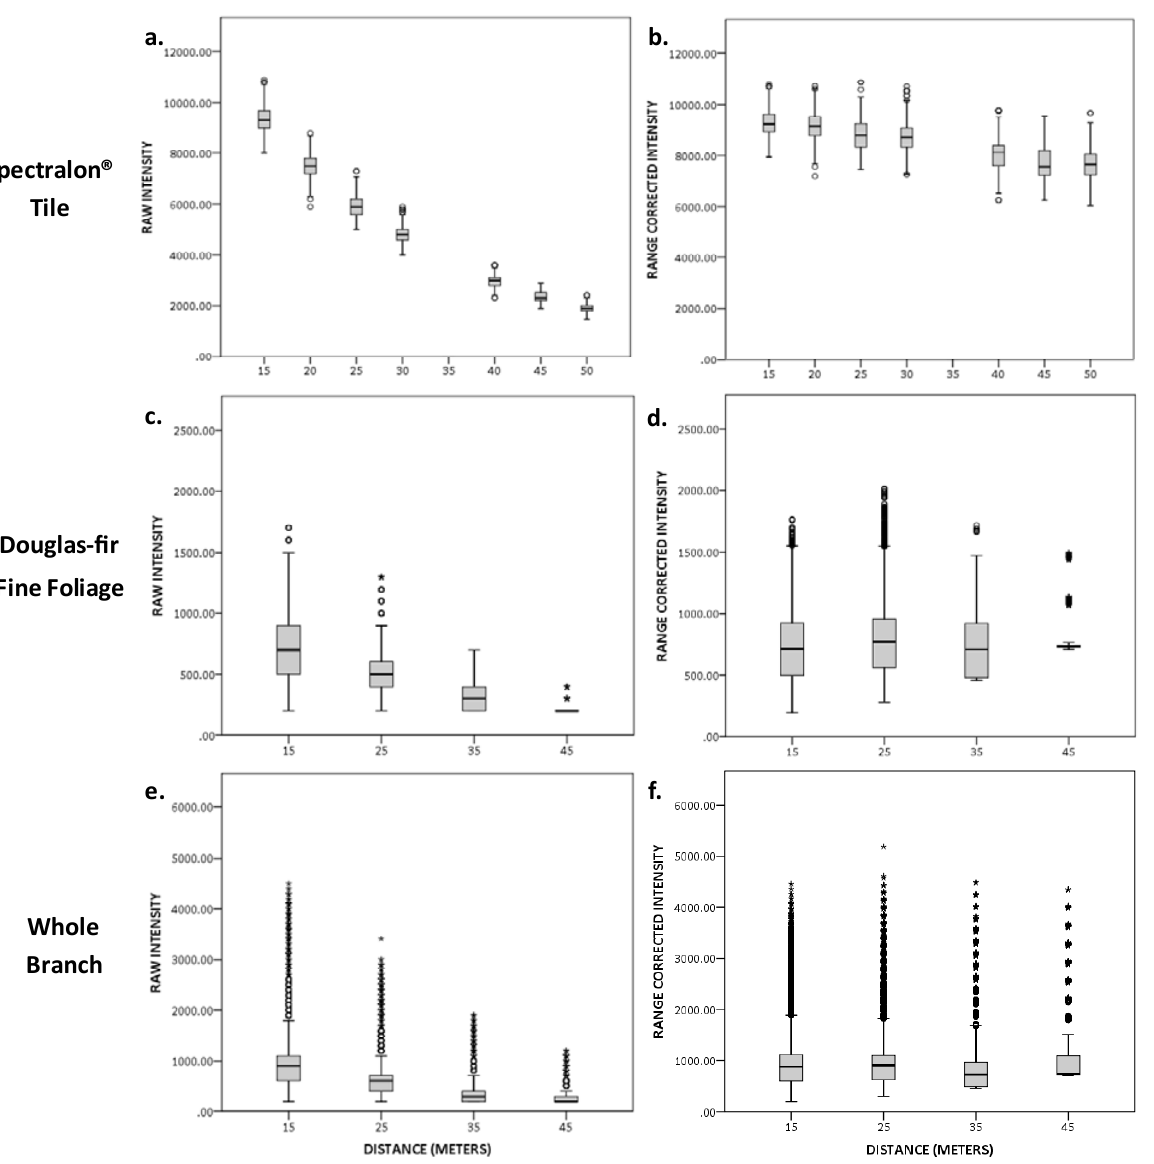
Figure 7. Box-and-whisker plots of intensity vs. target distance for a 98.7% albedo Spectralon tile and Douglas-fir whole branches and fine foliage in the 0° position. For each plot, the dark horizontal line represents the median value, and the grey box represents data from 25% to 75%. The fences extend to 1.5 times the height of each box and represent approximately 95% of the data. The circles are outliers, i.e. , data points that fall outside of the fence. Asterisks are extreme outliers, which are cases with values greater than three times the height of the box. (a) Raw Spectralon tile intensity vs. distance. intensity vs. distance. (d) Range-corrected Douglas-fir fine foliage intensity vs. distance. whole branch intensity vs.